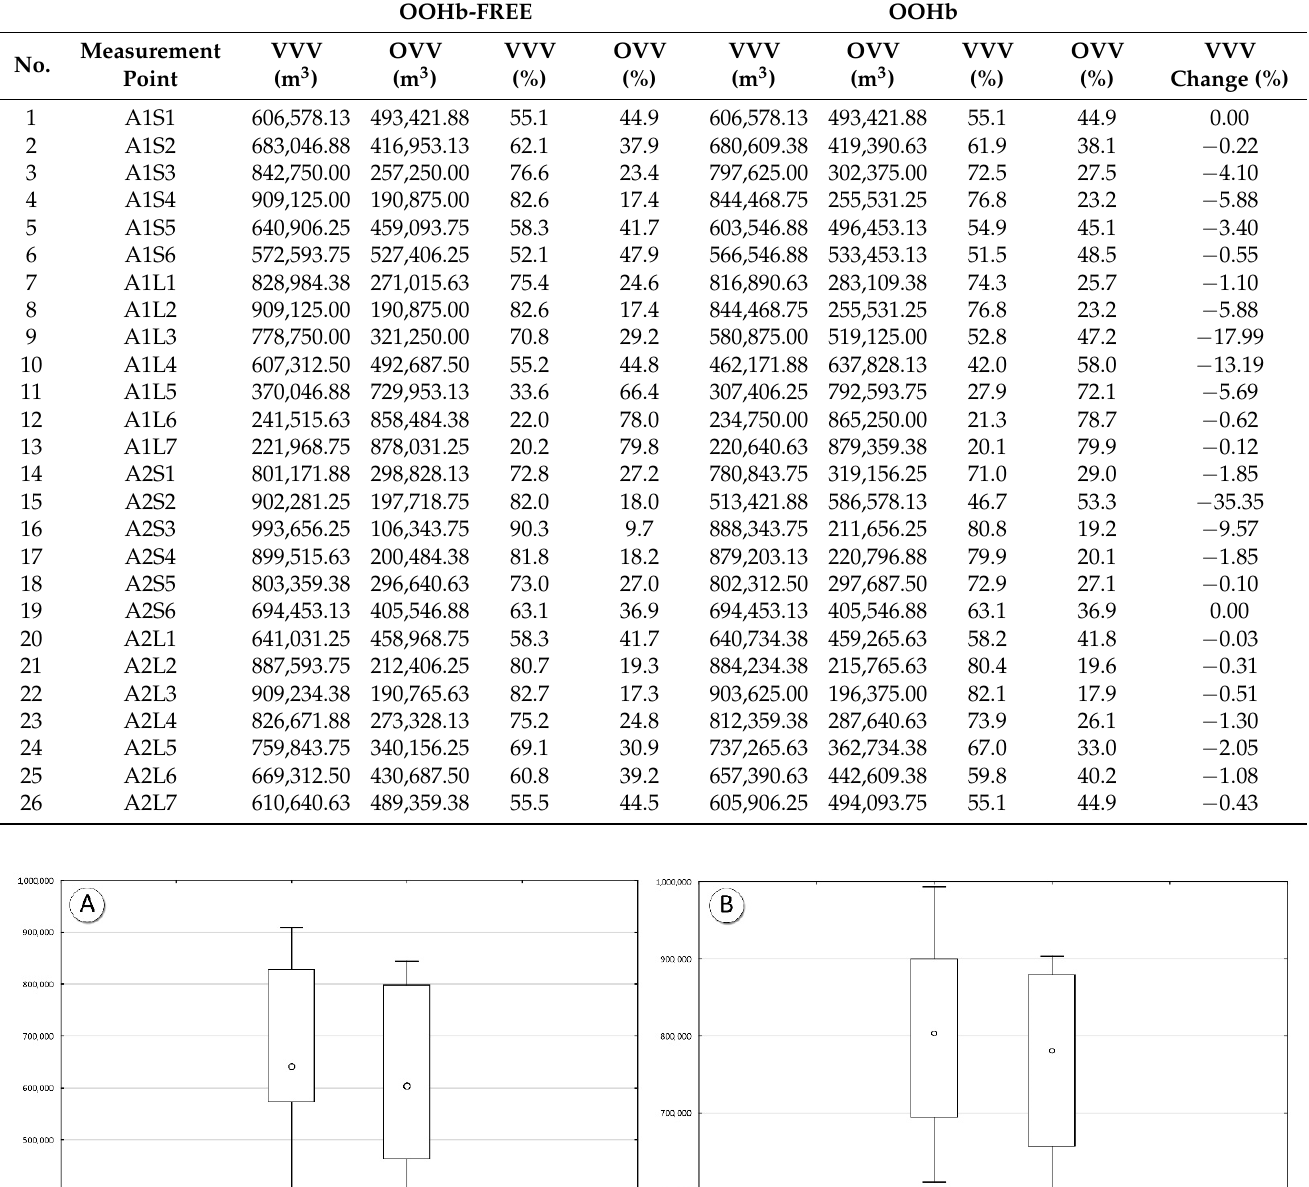
Table 2. The VVV–OVV balance results for “OOHB-free” and “OOHb scenarios”. OOHb-FREE OOHb